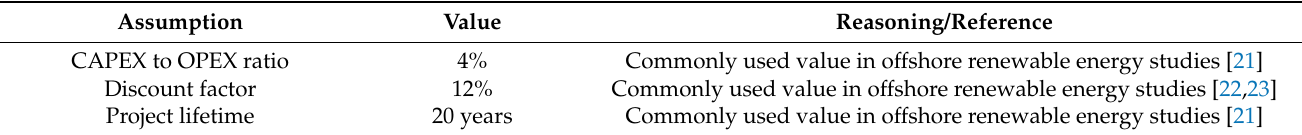
Table 2. Universal assumptions used for extended reverse LCOE calculation for all